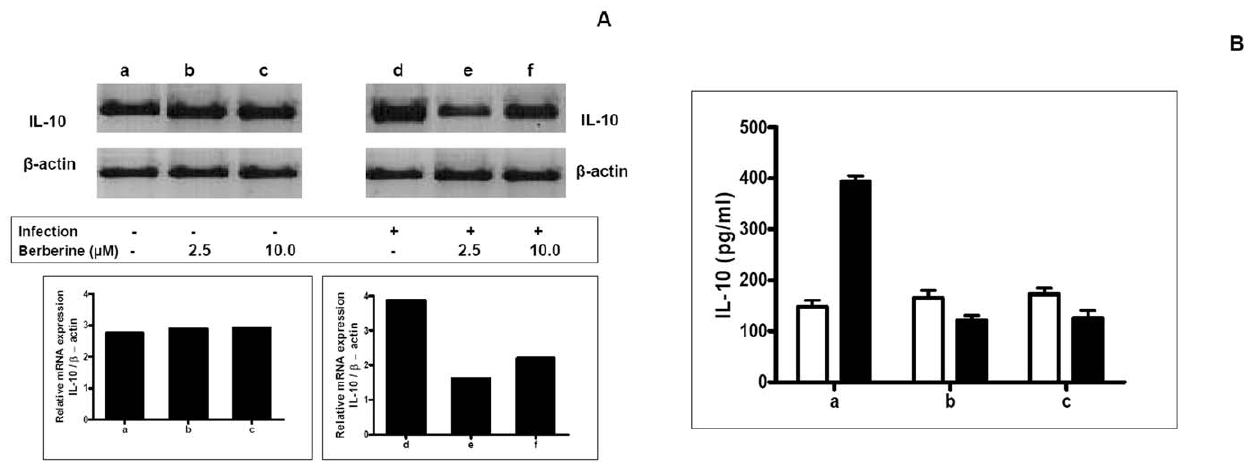
Figure 4. Effect of Berberine chloride on IL-10 in macrophages. A: Uninfected (a) and L. donovani infected (d) macrophages were treated for 18 h with Berberine chloride 2.5 m M (b, e) or 10 m M (c, f). RNA was isolated, subjected to RT-PCR and the products of b -actin and IL-10 mRNA were resolved on an agarose gel (1.5%) and quantified densitometrically using Total lab software as described in Methods. B: Uninfected macrophages (1 6 10 6 /ml, % , a) or L. donovani infected macrophages ( & , a) were treated with Berberine chloride 2.5 m M (b) and 10 m M (c) for 24 h and assayed for levels of IL-10 in culture supernatants by ELISA as described in Methods. Each point represents the mean 6 SEM of IL-10 (pg/ml) of at least 3 experiments in duplicate.